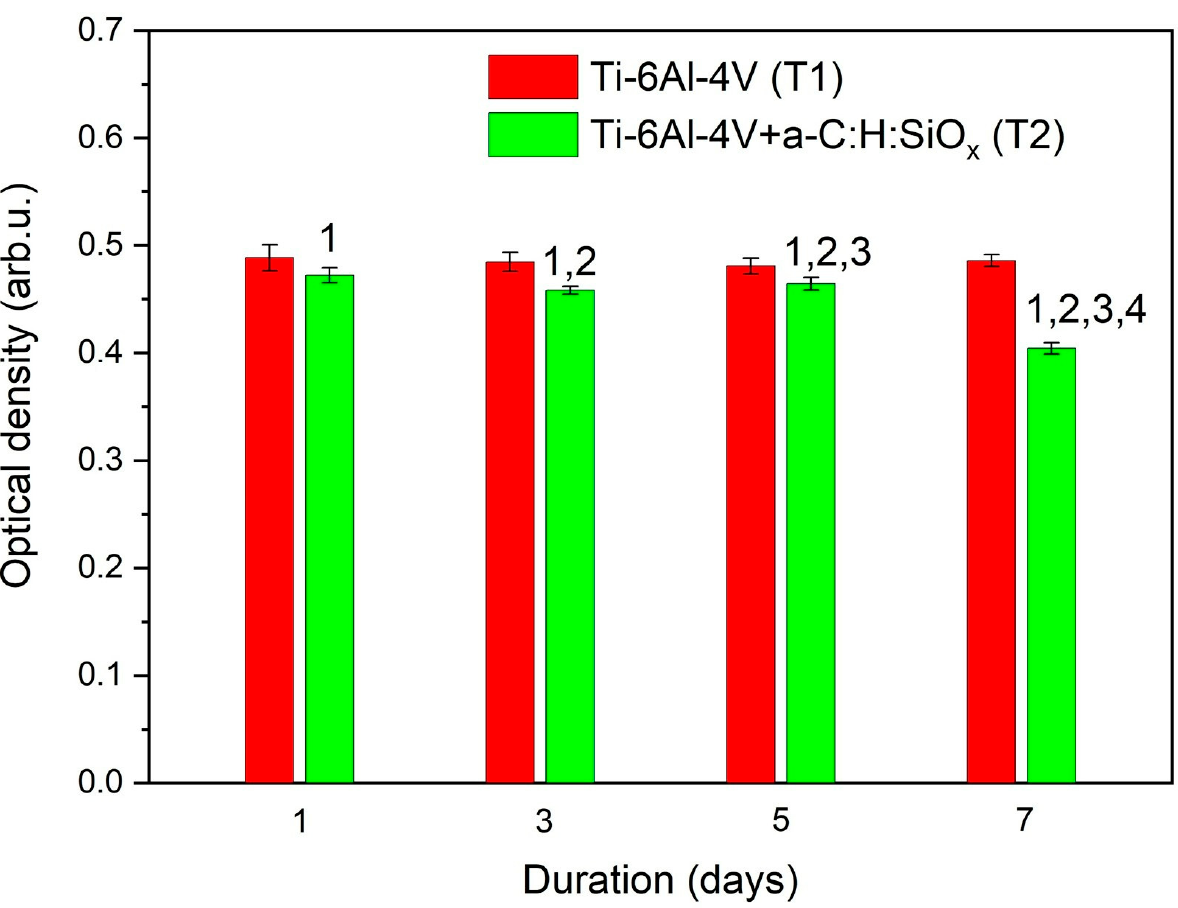
Vybrant™ CFDA SE Cell Tracer Kit (green), phalloidin (green), and DAPI (blue), respectively.